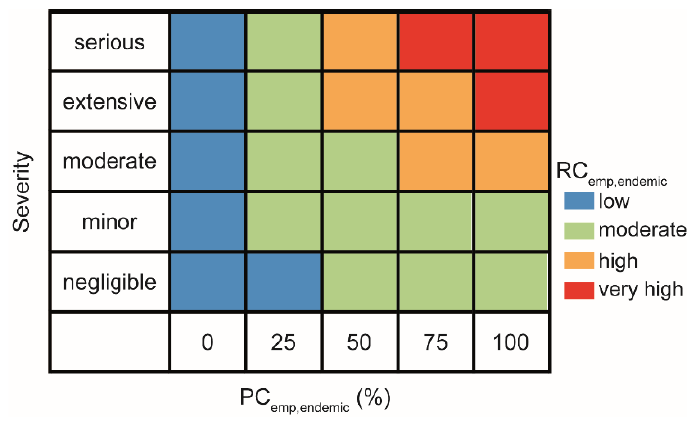
Figure 5. Combinations of severity and empirical probability of endemic storm damage events ( PC emp,endemic ) used to classify empirical endemic storm damage risk ( RC emp,endemic ).